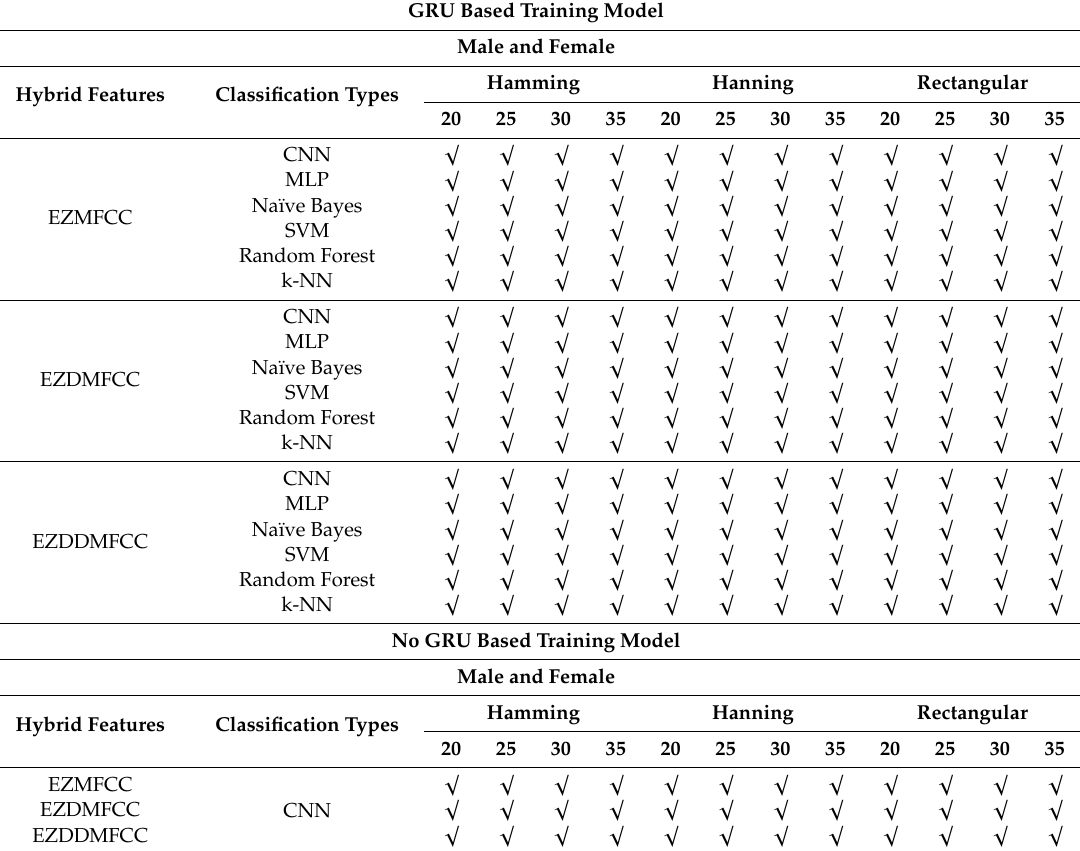
Table 11. Feature parameter sets and models.